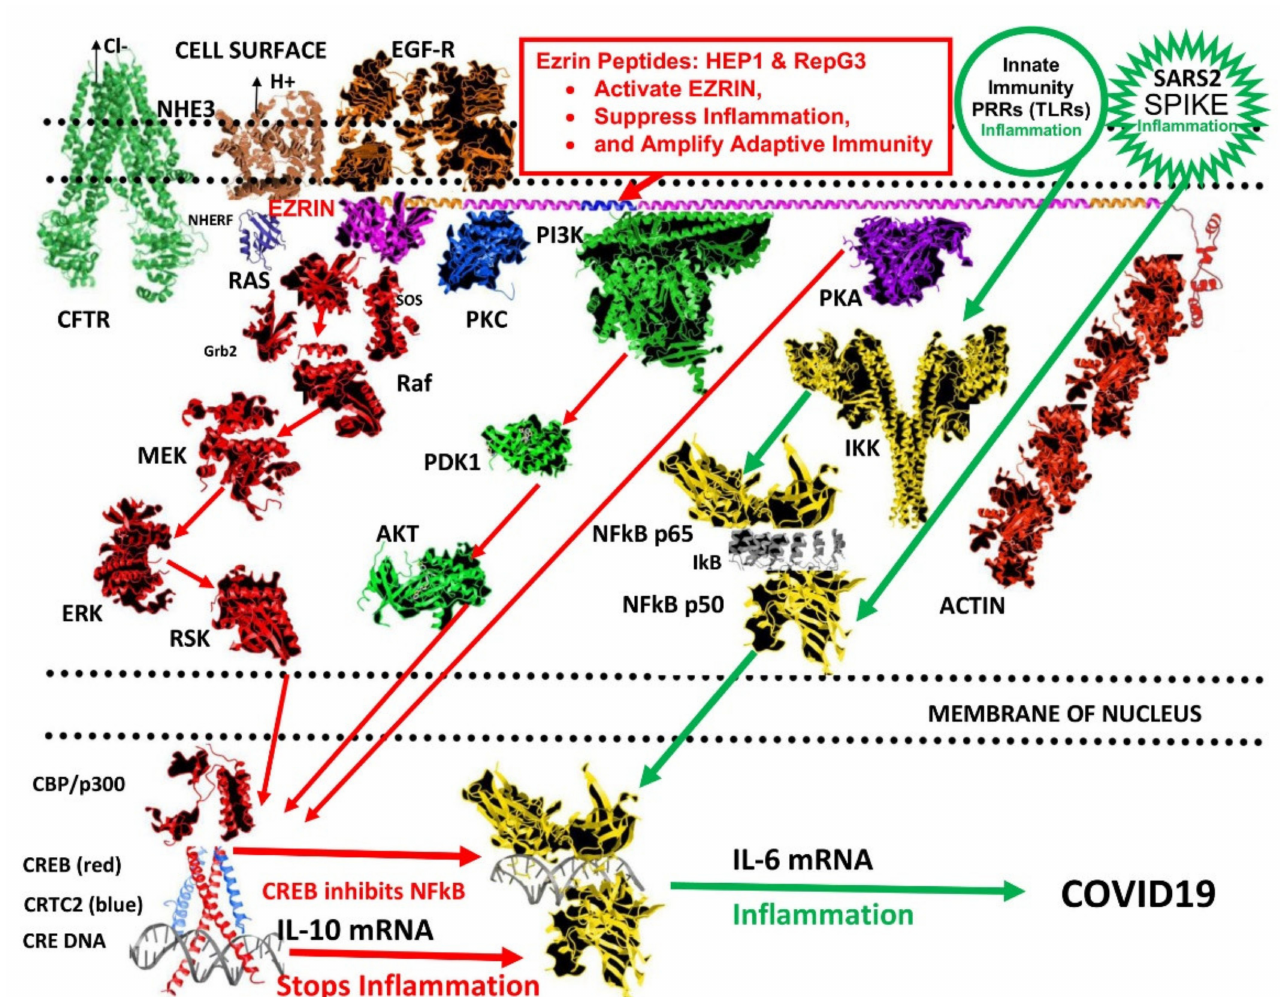
Figure 17. A hypothetical model of the cell-signalling pathways leading to the induction of excess inflammation by SARS- CoV-2, contrasted with the possible site of action of ezrin peptides at ezrin and different cell control pathways that lead to suppression of inflammation. (images produced in Adobe Photoshop and Microsoft Word). Red arrows represent cell signalling pathways leading to suppression of inflammation. Green arrow represent cell signalling pathways leading to activation of inflammation. SARS-CoV-2 spike-protein triggers cell-surface pattern recognition receptors (PRRs) such as toll-like receptors (TLRs) that are associated with innate immunity, to initiate inflammatory responses via multiple pathways to IKK (yellow) and activation of transcription factor NFkB (yellow), which migrates to the nucleus and binds to DNA at a spectrum of gene-promotors (grey), which initiate the expression of inflammatory cytokines such as IL-6. In contrast, active-ezrin assembles cell-signalling complexes associated with adaptive immunity such as PKA (purple), PI3K > PDK1 > AKT (green), PKC (blue) and SOS + Grb2 + RAS > Raf > MEK > ERK > RSK (red left), together with actin reorganization associated with receptor clustering and the formation of the immunological synapse (red right). In the nucleus, downstream effectors of PKA (purple) AKT (green) and RSK (red) activate transcription factor CREB (red) which scavenges CBP/p300 (red), so this co-factor is unavailable for NFkB mediated gene transcription (yellow). CREB (red) combines with CRTC2 (light blue) to engage CRE DNA and initiates the expression of anti-inflammatory IL-10, which also inhibits inflammation. It is interesting that cystic fibrosis symptoms are similar to COVID and the cystic fibrosis transmembrane conductance regulator CTFR (light green left) that controls mucus membrane hydration in the airways, is closely associated with ezrin via a complex with NHERF and NHE3. Ezrin activation is also controlled by the epidermal growth factor receptor EGF-R (brown). Signals induced by ezrin peptides, are thought to bias cell-signalling systems and transcription-factor usage, from innate immune responses to adaptive immune responses, suppressing inflammation in the process. (other ezrin-associated cell-surface proteins such as: CD44, CD43, ICAM1, ICAM2 and CD95 are not depicted to avoid cluttering the